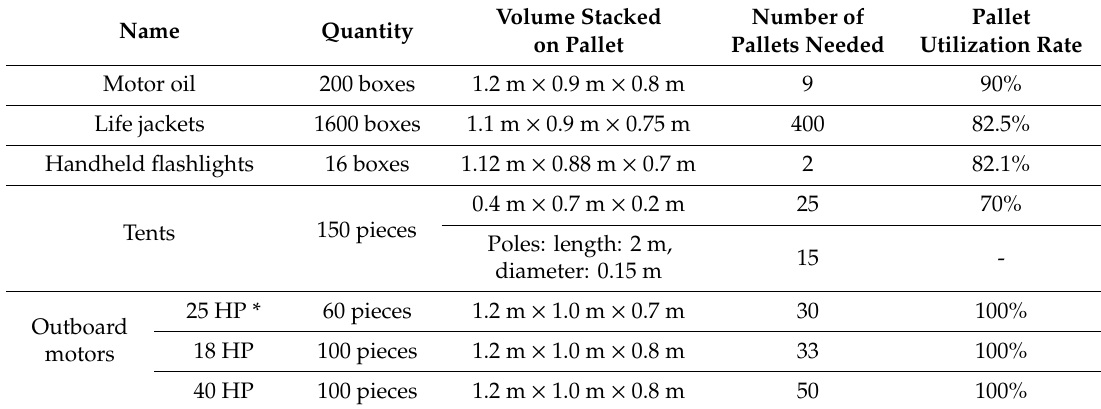
Table 5. Material types, quantities, and stacking arrangement.